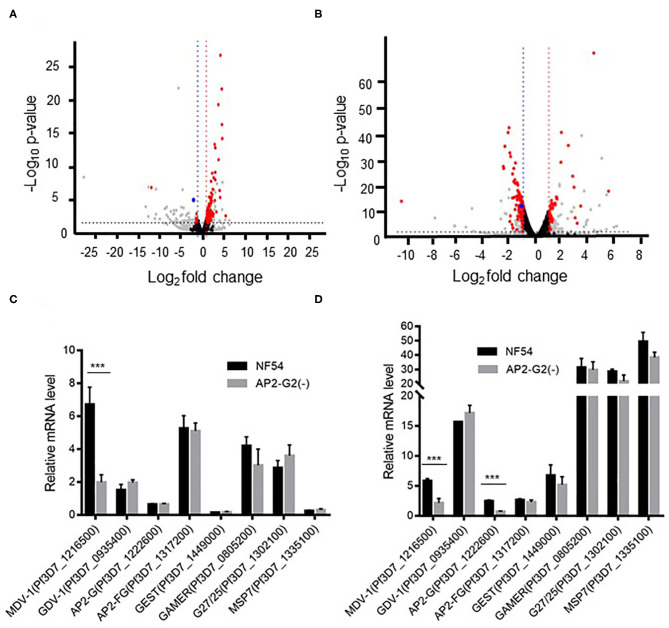
Transcriptomic analysis of NF54 and the PfAP2-G2(-) parasites by RNA-seq. (A,B) Volcano plot of log2 fold change (x axis) in gene expression of PfAP2-G2(-) parasites vs. NF54 parasites in ring stage (A) and schizont stage (B) against the significance of change shown as the –log10
p-value (y axis). Red dots indicate genes with significant changes in expression level. Blue dots indicate the PfMDV-1 gene. Gray dots indicate genes whose TPM was <10. Black dots indicate genes whose p-value was more than 0.05 or | log2 fold change | was <1 (C,D) RT-qPCR validation of the RNA-seq data using selected genes essential for gametocyte development at the ring (C) and schizont (D) stages. A gene (MSP7), which is unrelated to gametocyte development, was used as a negative control. Primers for RT-qPCR are shown in Supplementary Table 1. The experiment was repeated three times. All error bars indicate SD. ***P < 0.001.